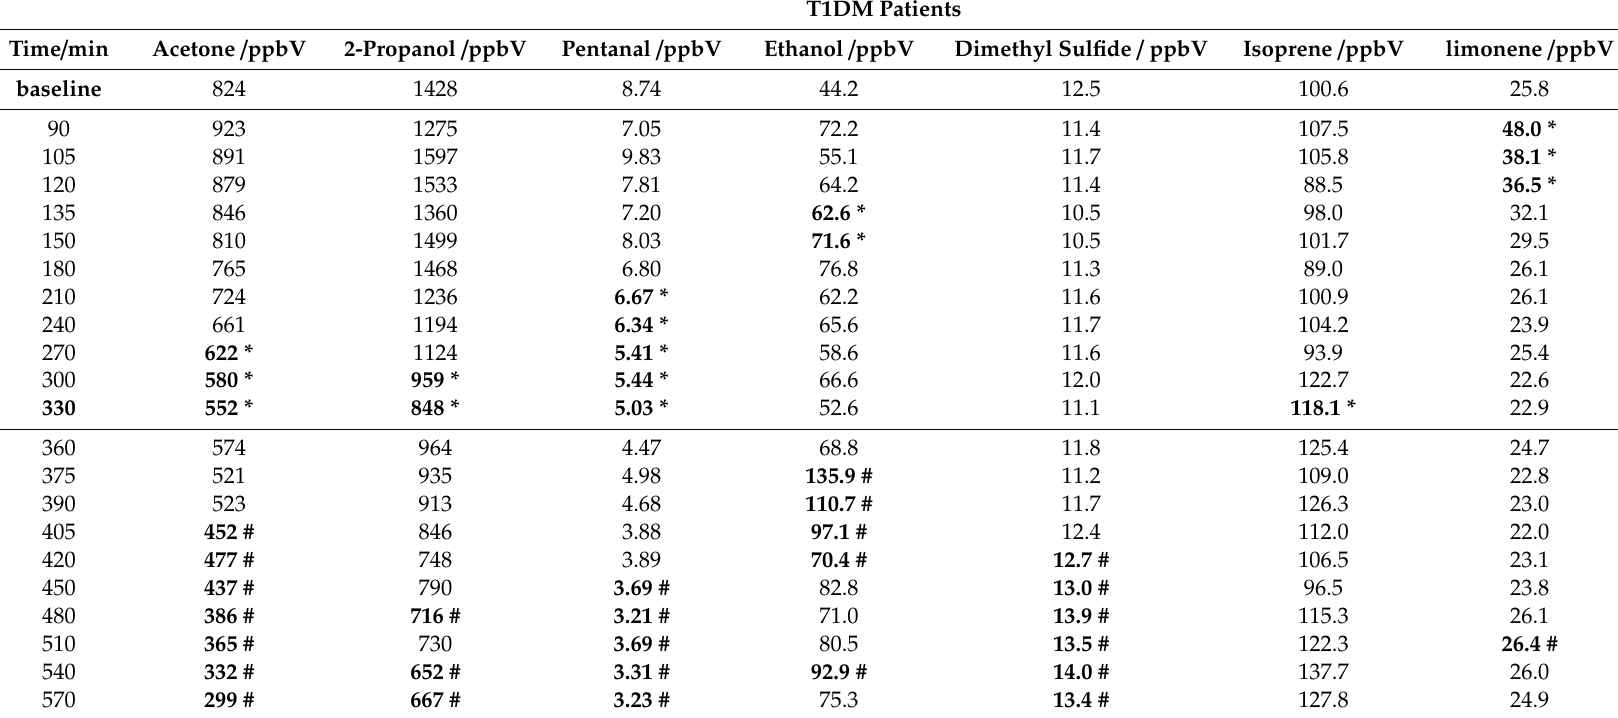
Table 3. Time resolved analysis of volatile organic compounds (VOC) concentrations. Per group and parameter, data for median is given and significant changes (repeated measurement ANOVA on ranks in combination with Dunn’s method for pair-wise multiple comparisons versus control), are marked in bold and with an asterisk or hash, respectively. Significant changes in the first half of the experiment versus baseline (min 60, immediately before breakfast) are marked with an asterisk (*) and significant changes in the second half of the experiment versus minute 330 (immediately before lunch) are marked with a hash (#). P-values of 0.05 or lower were considered as